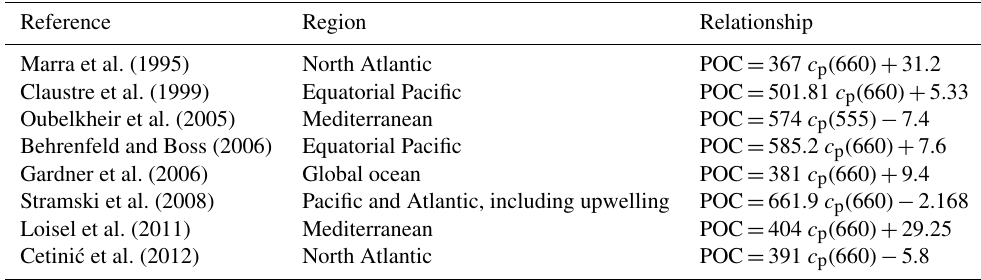
Table 1. POC-to- c p relationships from the literature (with POC and c p in units of mgm − 3 and m − 1 , respectively).